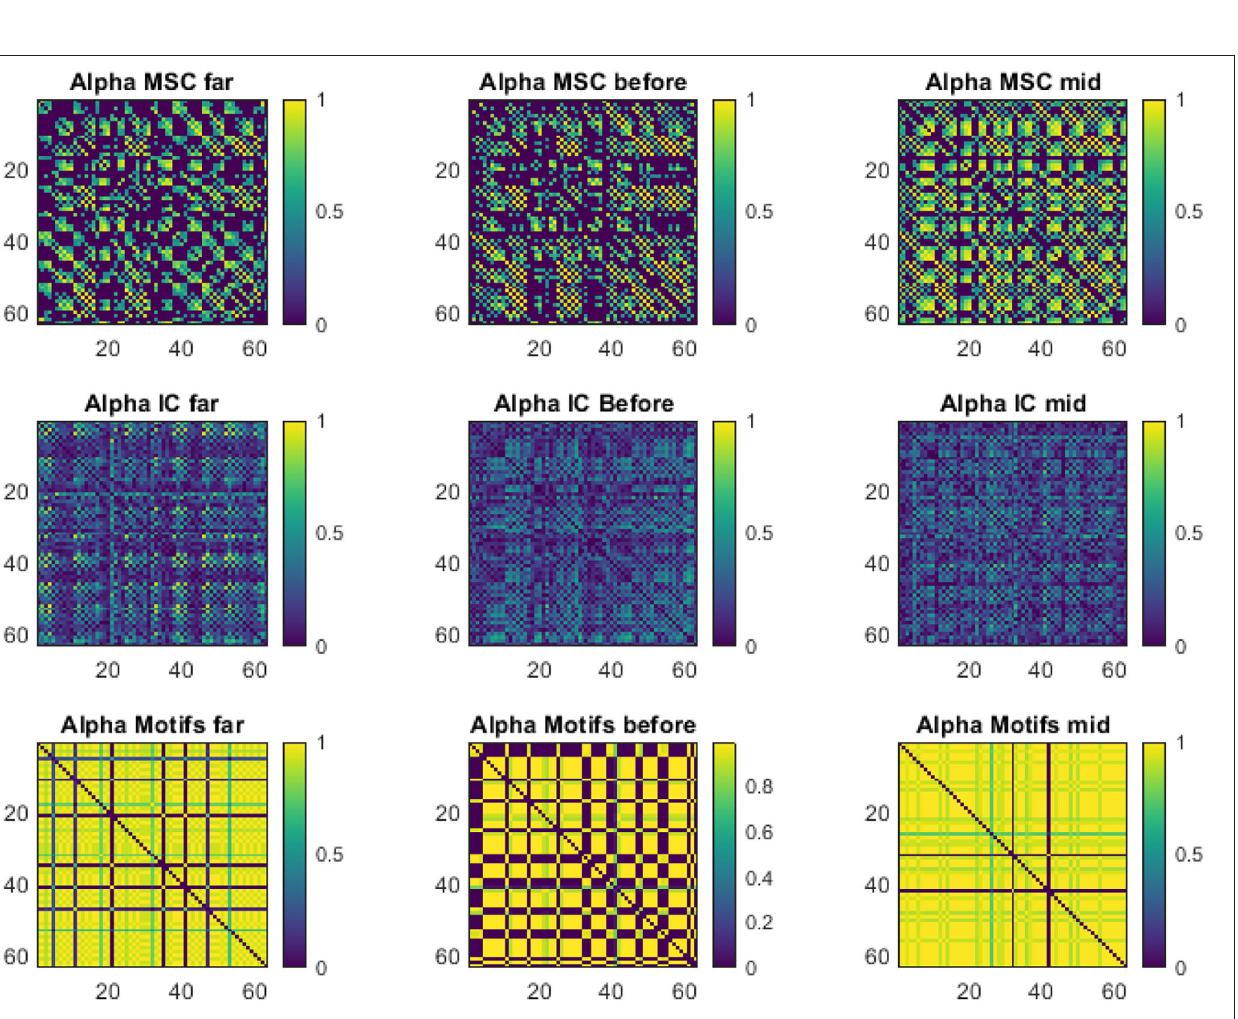
Frontiers in Neurology |